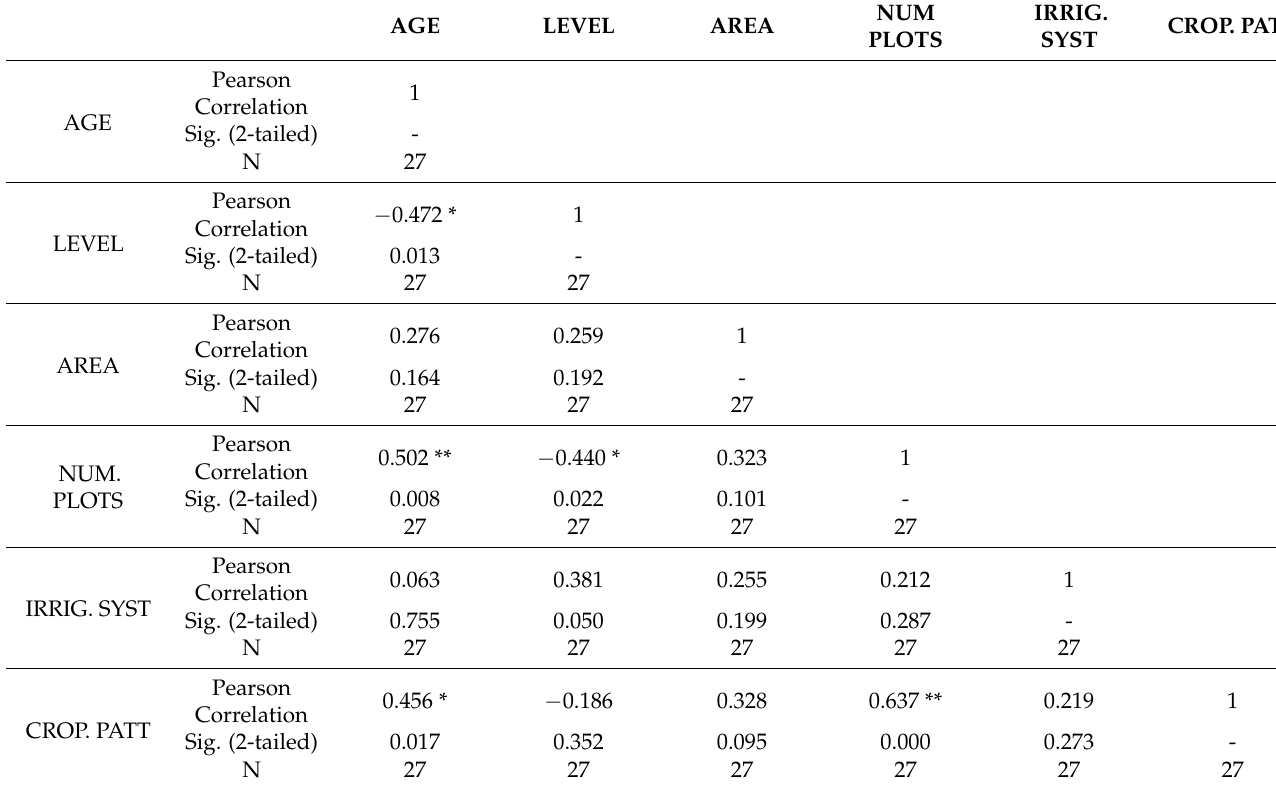
Table 2. Correlation of the main variables of farmer profiling. AGE LEVEL AREA